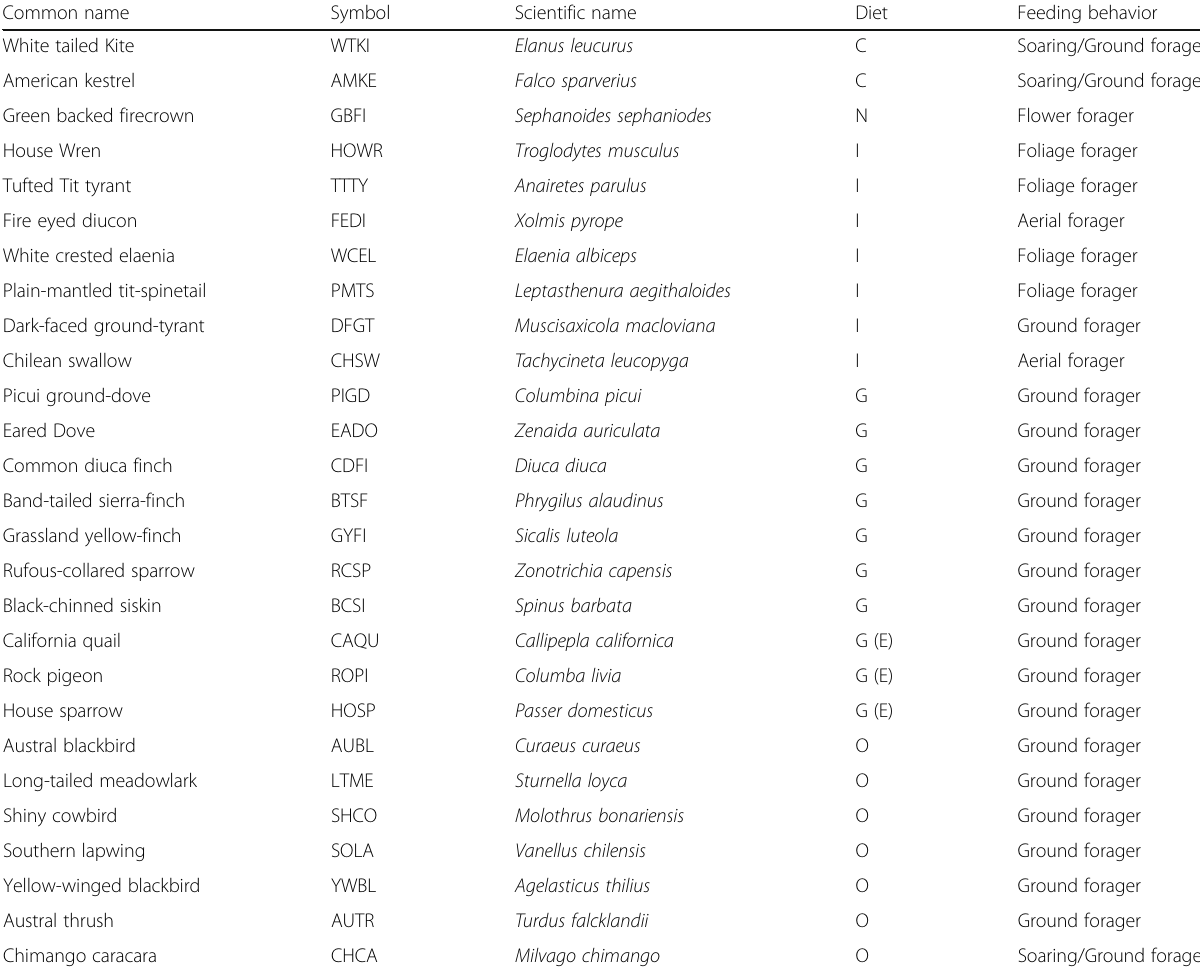
Table 2 Bird species analyzed and dietary group (G granivores; I insectivores; O omnivores; C carnivores; N